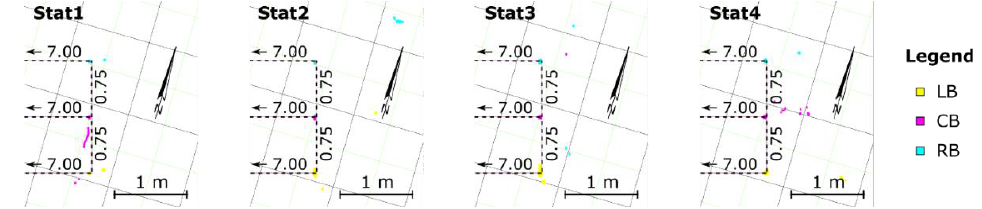
Figure 6. Back- line receivers’ post -processed coordinates from four sessions. Figure 6. Back-line receivers’ post-processed coordinates from four sessions. The colors representing six GNSS receivers correspond to the time series presented in Figure 2. Fixed linear dimensions used in the railway platform were added to the figures to highlight the outliers recorded during the field campaign.